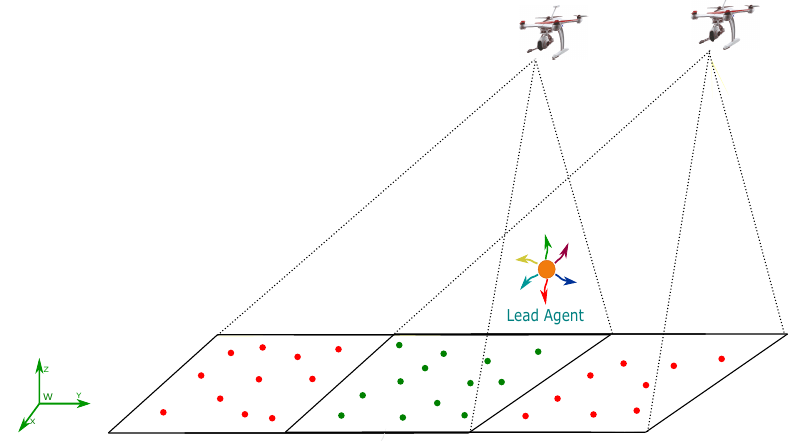
Figure 1. Multi-UAV SLAM system with a dynamic lead